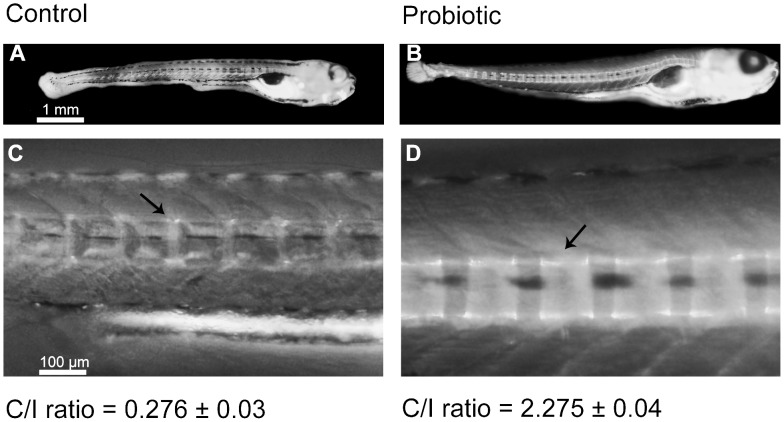
Backbone calcification.Two representative pictures showing backbone calcification of zebrafish larvae at 12 days post fertilization (dpf) from control (A, n = 10) and probiotic group (B, n = 10) respectively (3 replicates). 10× magnification of the centra (black arrows) and the Centra/Intracentra ratio with average values are reported (C and D).